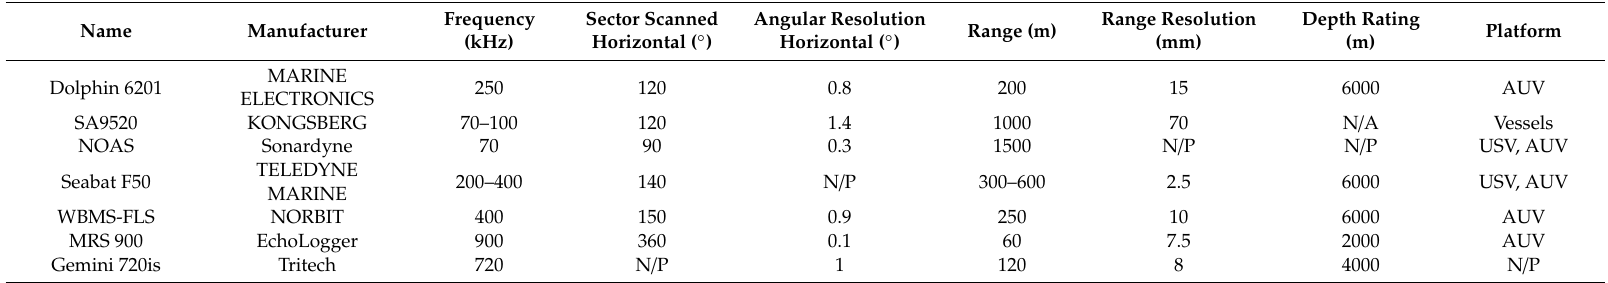
Table 10. Acoustic sensor: obstacle avoidance sonar (OAS).